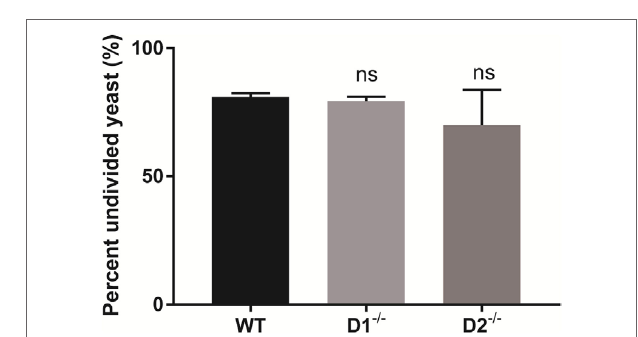
FigUre 7 | Spleen tyrosine kinase-mediated control of Candida glabrata is independent of Dectin-1 and Dectin-2. Percent undivided carboxyfluorescein succinimidyl ester-bright C. glabrata population from peritoneal macrophages-yeast co-cultures. Macrophages were obtained from wild type, Dectin-1 − / − , and Dectin-2 − / − mice. Comparisons between all groups are non-significant. Data represent a minimum of three independent experiments.